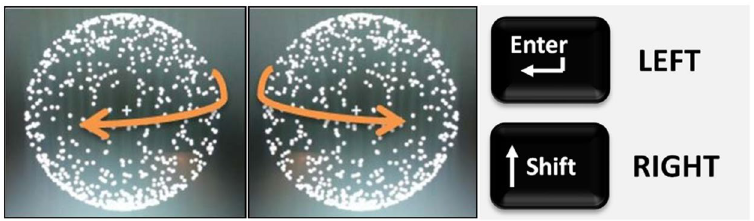
Figure 5. Mnemonics for the perceptual interpretations of the ambiguous structure-from-motion stimulus; LEFT, RIGHT and the key